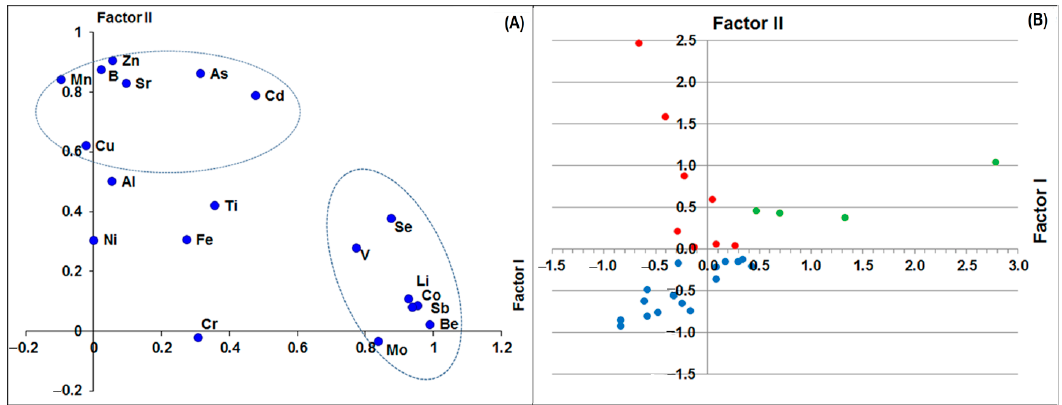
Figure 8. The distribution of the elements in the plane of the first two factors ( A ). The distribution of all collected aerosol samples in the plane of Factors I and II along the route of the RV «Akademik V.A. Koptyug» from 24 July to 4 August 2019 ( B ). During our measurements, the invasion of the air masses from the northern areas of the Irkutsk Region and the Krasnoyarsk Territory, which contained smoke from wildfires, was an additional source of the formation of aerosol particles in the atmosphere above the lake (see Figures 2 and 3). This can be seen in Figure 8B where Factor I is responsible for the soil aerosol and reflects the contribution of the sources in the aerosol above Southern and Central Baikal. Factor II marked in red in Figure 8B shows the contribution of the emission from wildfires in the composition of the aerosol along the east coast of Lake Baikal. Using Table 8, we can describe Factor II as the joint contribution of the group of the following elements in the formation of the elemental composition of aerosol particles: B, Mn, Zn, As, Sr, Cd, and Pb. This allowed us to use them as markers during the entry of air masses from the areas prone to wildfires. Aerosol samples are rather well separated in elements in the plane of Factors I and II (see Figure 8B). Aerosol samples exposed to smoke emission from wildfires are marked in red; those collected near settlements (Baikalsk, Severobaikalsk, and Nizhneangarsk), are marked in green, and aerosol collected in clean areas are marked in blue. Similarly, we conducted a factor analysis for the ionic (soluble) part of aerosols (Table 9, Figure 9). Accumulation and dissipation of ions in the soluble part of aerosol occurs differently than in the solid part due to the constant watering of the particles in the air. Therefore, the distribution of samples on the plane of the first two factors has shown in this case (Figure 9B) that the first factor is the effect of the forest fire emissions (the incidence is marked in red), and only the second factor is responsible for the soil aerosol (marked in blue). Based on Table 9, we can predict that during the influx of smoke air masses, the soluble part of aerosols is enriched with the NH 4+ , K + , SO 42 − , and Li + . Table 9. Factor loads of the analyzed ions in the soluble part of aerosol in the near-water atmospheric layer of Lake Baikal along the route of the RV “Akademik V.A. Koptyug” from 24 July to 4 August 2019 (the contribution of the factor to the general dispersion is indicated under the name of the factor). Ions